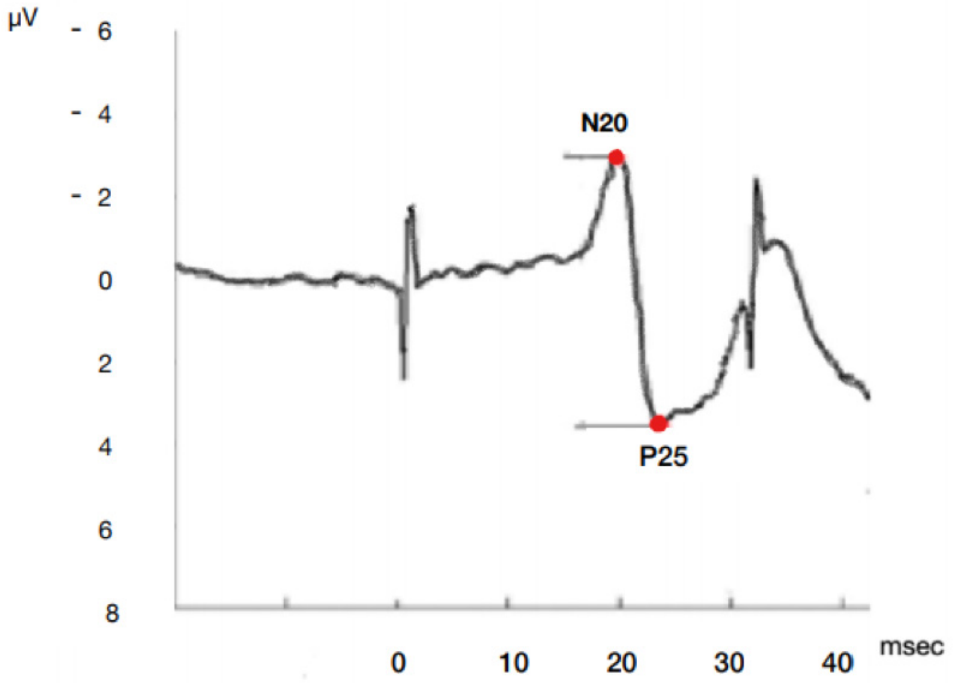
Figure 1. Model of SSEP N20P25 cortical complex wave onset and peak amplitude and latency by median nerve stimulation. µ V microvolt, msec milliseconds.